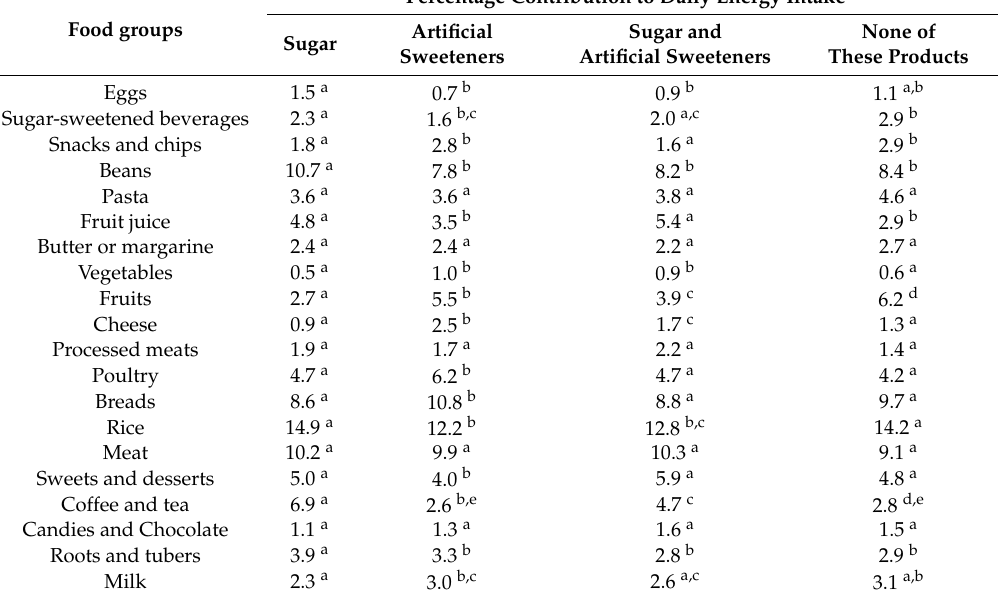
Table 3. Contribution (%) to the daily intake of energy of the food groups according to the type of sweetener. Brazil, National Dietary Survey,